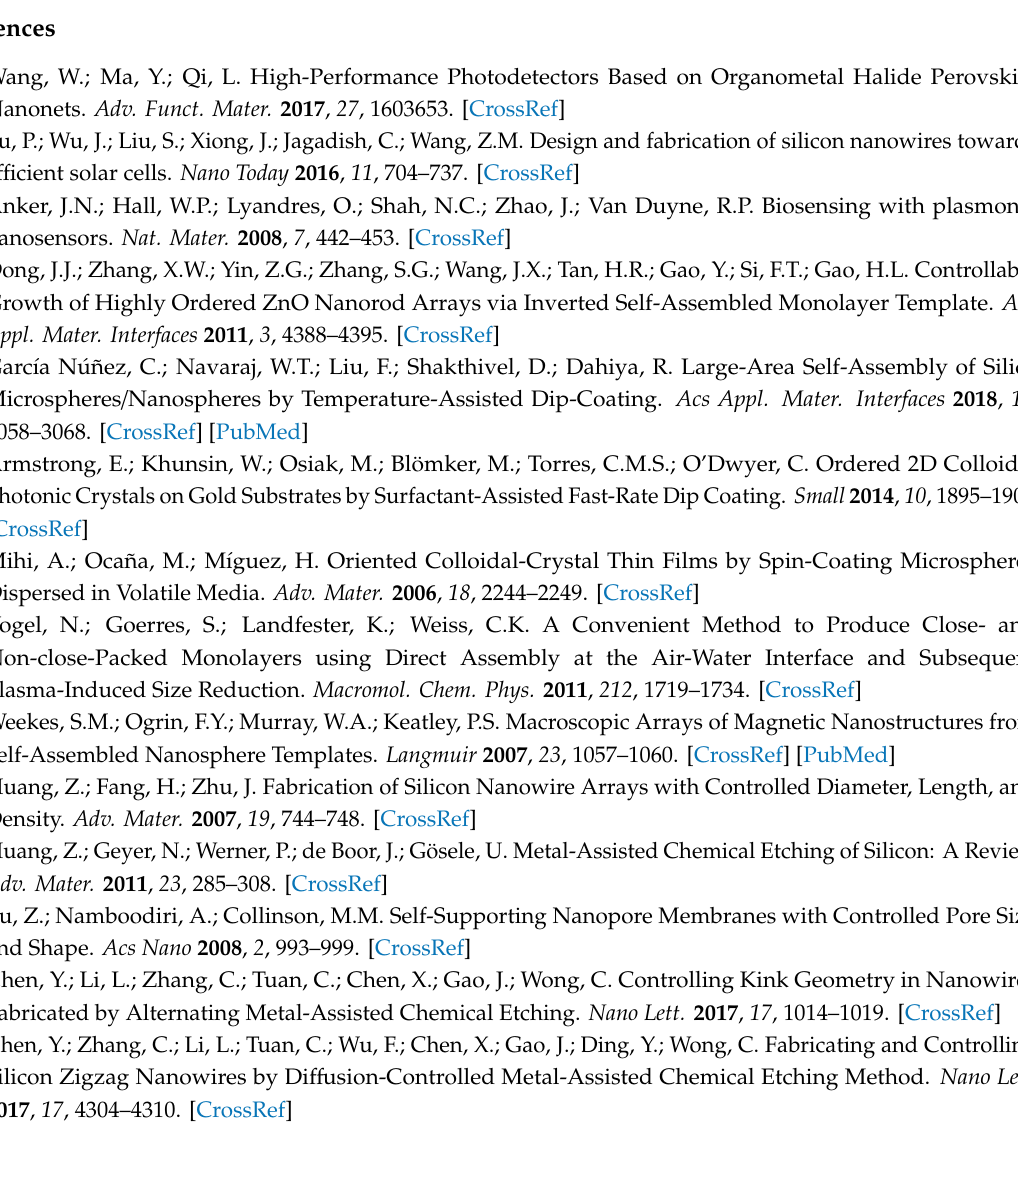
Figure S1: Surface morphology of individual nanosphere after plasma etching measured by AFM, Table S1: The details of etching conditions to obtain the results of Figures 1 and 2, Table S2: Detailed data of Figure 2c, Table S3: Detailed data of Figure 2d, Table S4. Detailed data of Figure